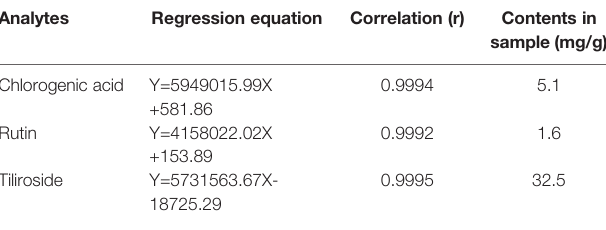
TABLE 2 | The contents of chlorogenic acid, rutin, and tiliroside in WEE. Analytes